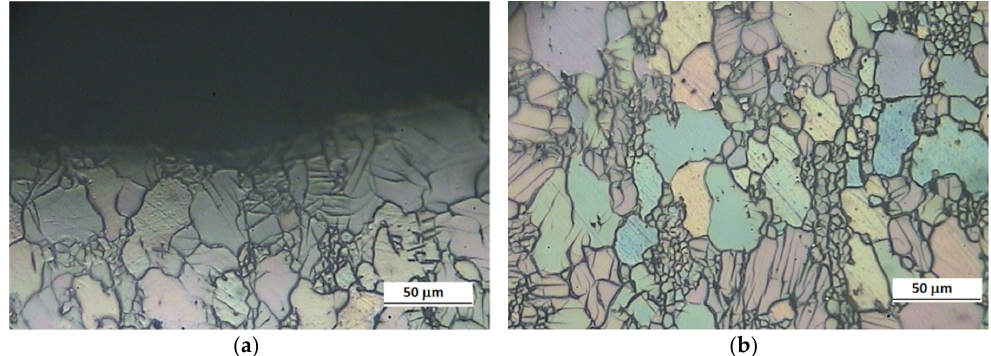
Figure 10. ( a ) Cross-section of the crater and ( b ) of the zone just below.